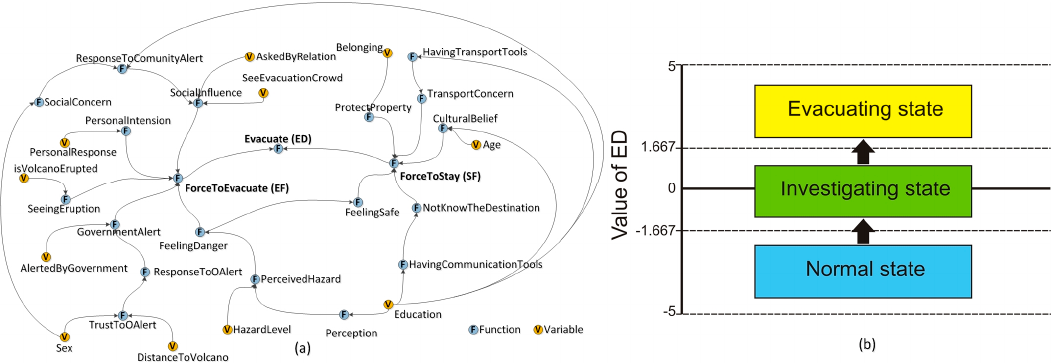
Figure 3. Threshold-based decision rule based on the Normal-Investigating-Evacuating state model. ( a ) The interrelating variables and functions define the value of the evacuation decision (ED); and ( b ) the transition between states in the evacuation decision as result of changing ED based on the threshold model. Descriptions of the variables and functions are provided in the supplementary materials (Supplementary Material—Appendices 5–7).